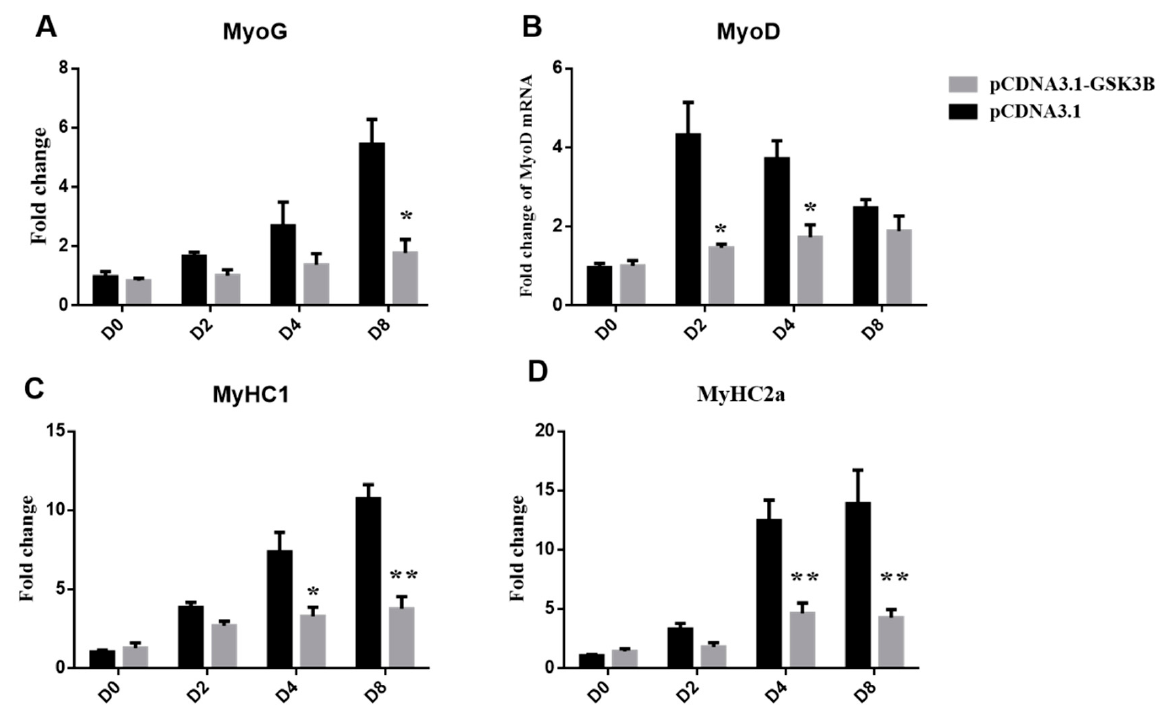
Figure 2. GSK3 β decreases expression levels of myogenic genes in sheep SMSCs. ( A – D ) The expres- sion levels of MyoG , MyoD , MyHC1 , and MyHC2a genes. All data are expressed as mean ± S.E.M. ( n = 6). p < 0.05 (*) and p < 0.01 (**) relative to control (pcDNA3.1+).